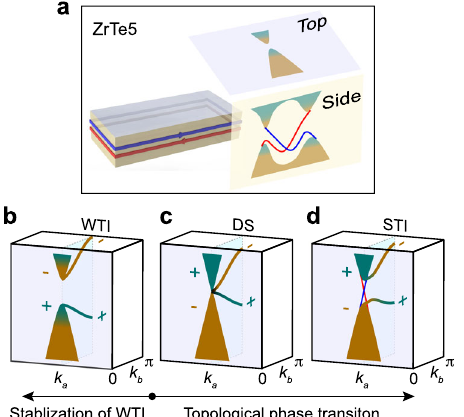
Fig. 4 Weak topological insulator state of ZrTe 5 and control of its topological phase. a In ZrTe 5 , there are surface states on the side surface, while no surface state exists on the top surface. b – d Topological phase transition in ZrTe 5 . The WTI state of ZrTe 5 can be stabilized by tensile strain ( b ), and a topological phase transition to DS ( c ) or even STI ( d ) can be obtained by compressive strain. There are two band inversions at k b = 0 and k b = π in the WTI state of ZrTe 5 . The band inversion at k b = 0 is switched by external strain in b – d , while the band inversion at k b = π has no